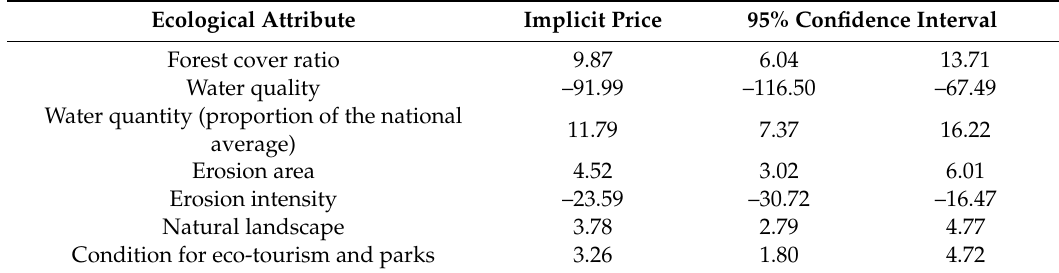
Table 7. Implicit prices (marginal willingness to pay (WTP)) for the ecological